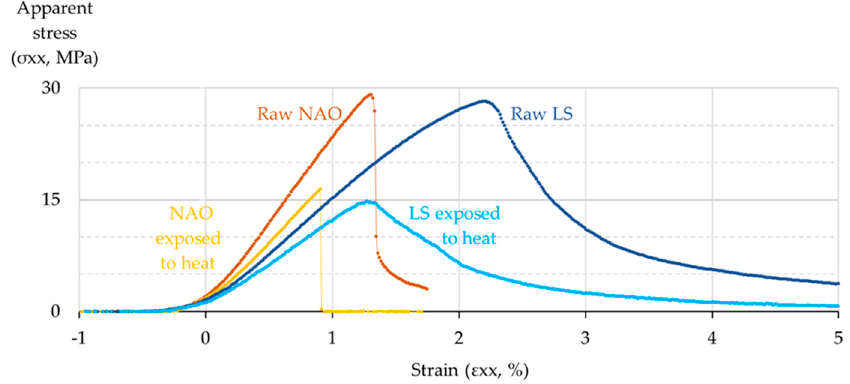
Figure 15. Graph of stress and strain in three-point flexure for the NAO and the LS materials, in the raw state and after exposition to heat.